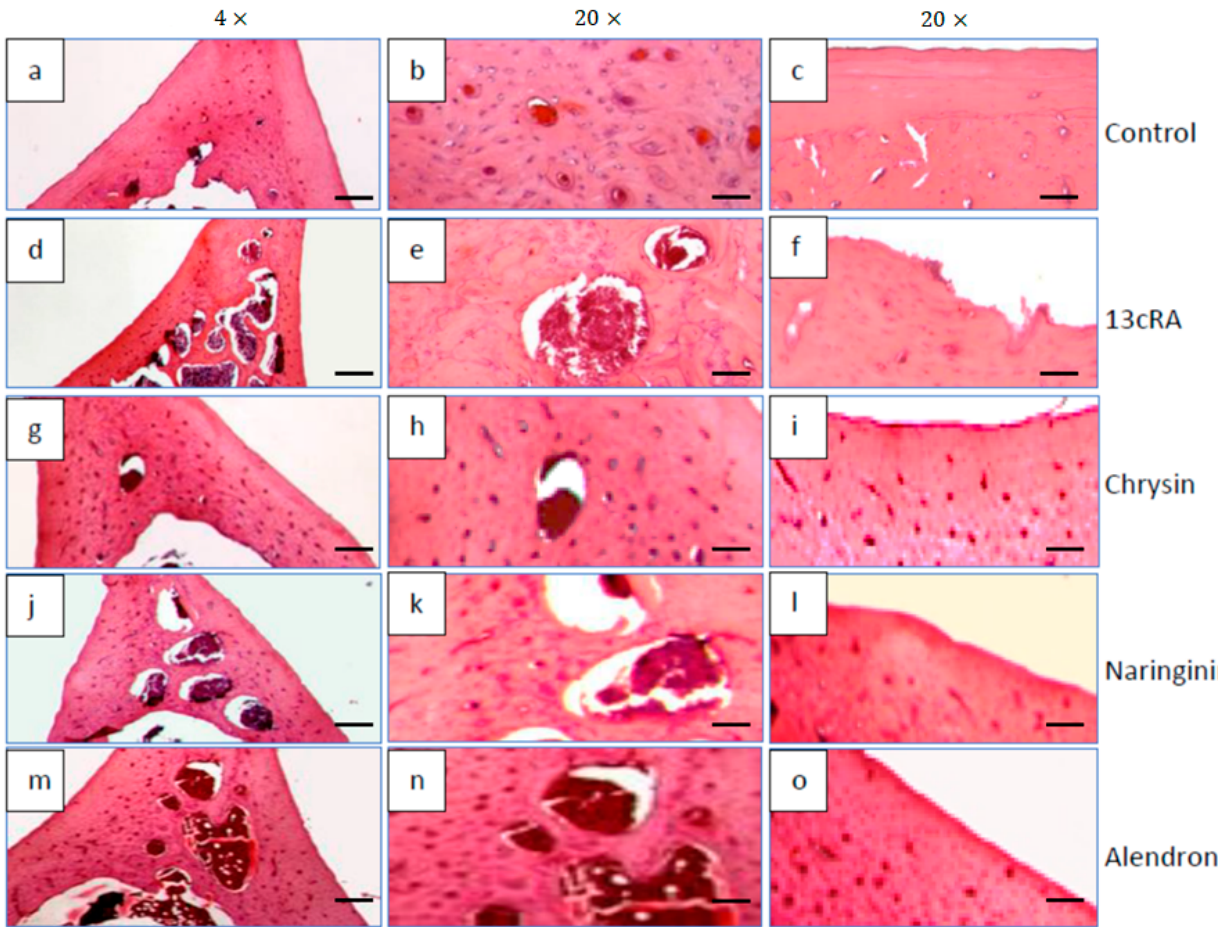
Figure 9. Effects of naringenin, chrysin, or alendronate on femur bone morphology in rats with retinoic-acid-induced osteoporosis. All sections were stained with H&E and examined under 4× (scalebar = 200 μ m) and 20× (scalebar = 50 μ m) magnification. Detailed descriptions of the images are provided in the text ( a – o ).